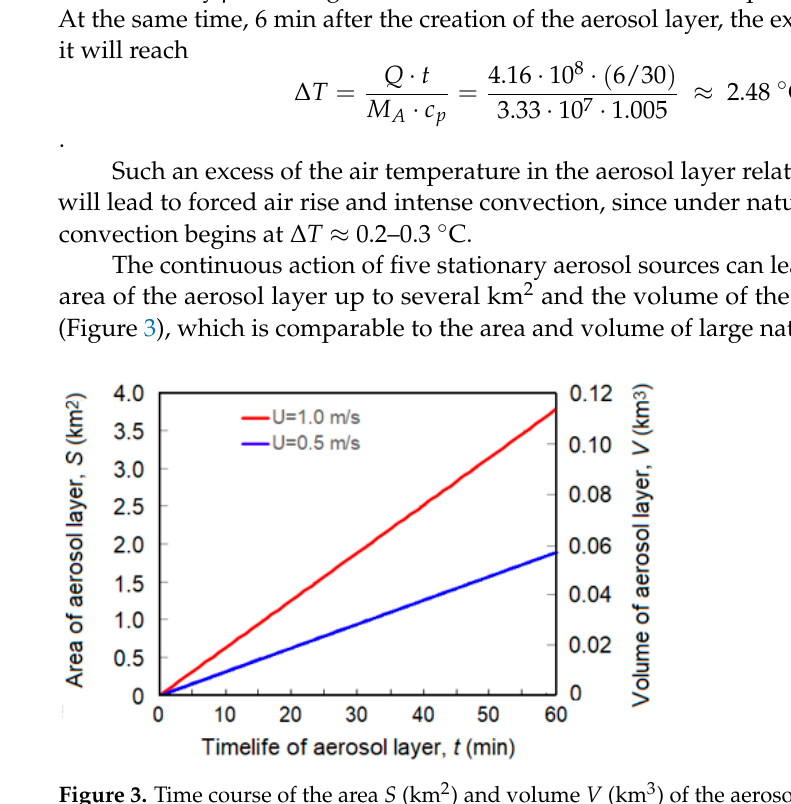
Figure 3. Time course of the area S (km 2 ) and volume V (km 3 ) of the aerosol layer that can be created by 5 continuous point aerosol sources placed along a line perpendicular to the wind direction 200 m apart at wind speed U = 0.5 and 1.0 m/s.